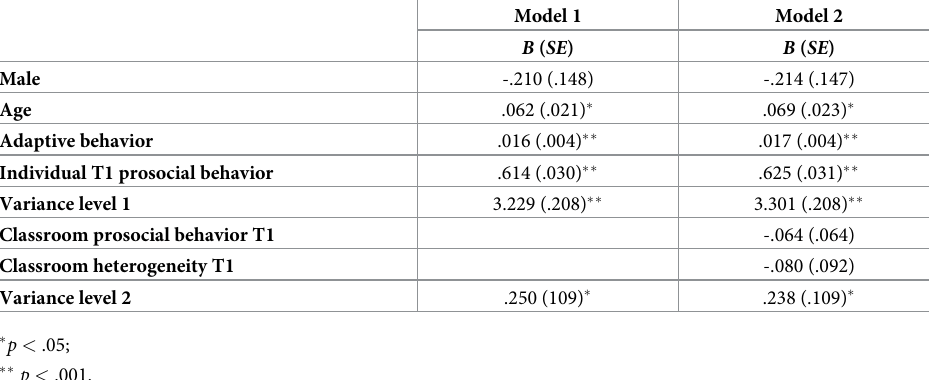
Table 3. Unstandardized results from longitudinal models predicting T2 prosocial behavior based on T1 individ- ual variables and classroom prosocial